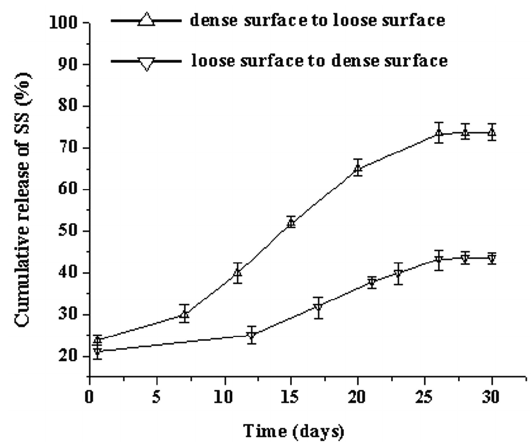
Figure 4. Cumulative release of SS from HCP scaffolds embedded with SS loaded collagen microparticles when SBF flowed along different